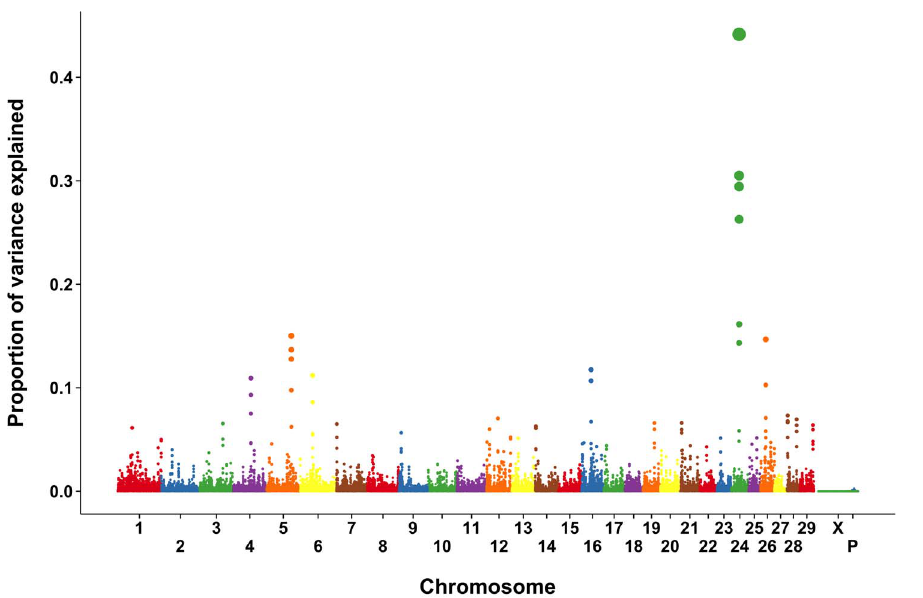
Figure 2. Proportion of SNP variance explained by 5-SNP moving windows for rectal temperature from a single-step GBLUP analysis.